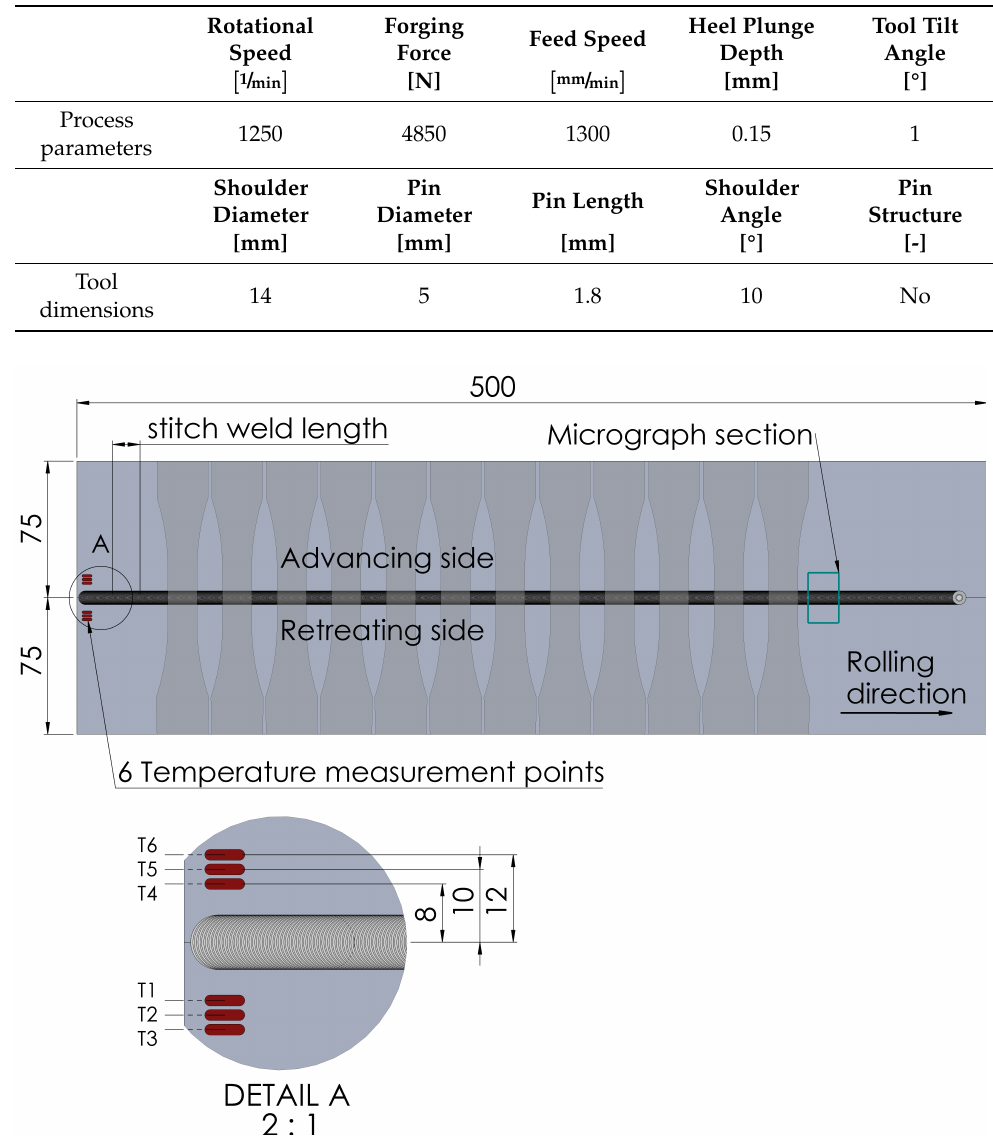
Figure 4. Specimen extraction from stitch welded sheets for tensile and fatigue testing, for micro- graphic analysis and measurement positions for thermocouples (all dimensions in